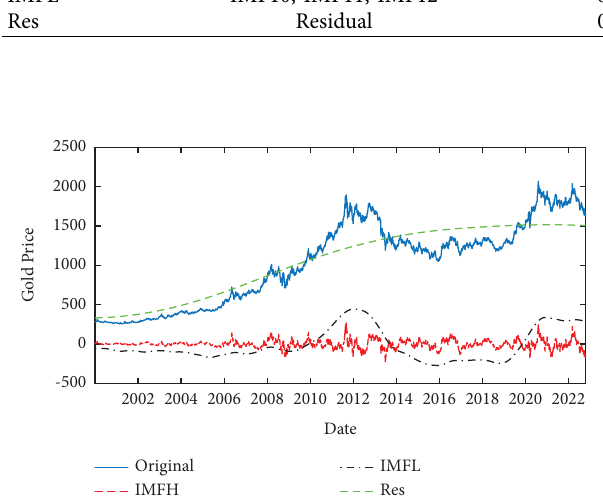
Figure 5: Reconstructed subsequence trend of the gold price Figure 6: In-sample forecasting results of the original gold price